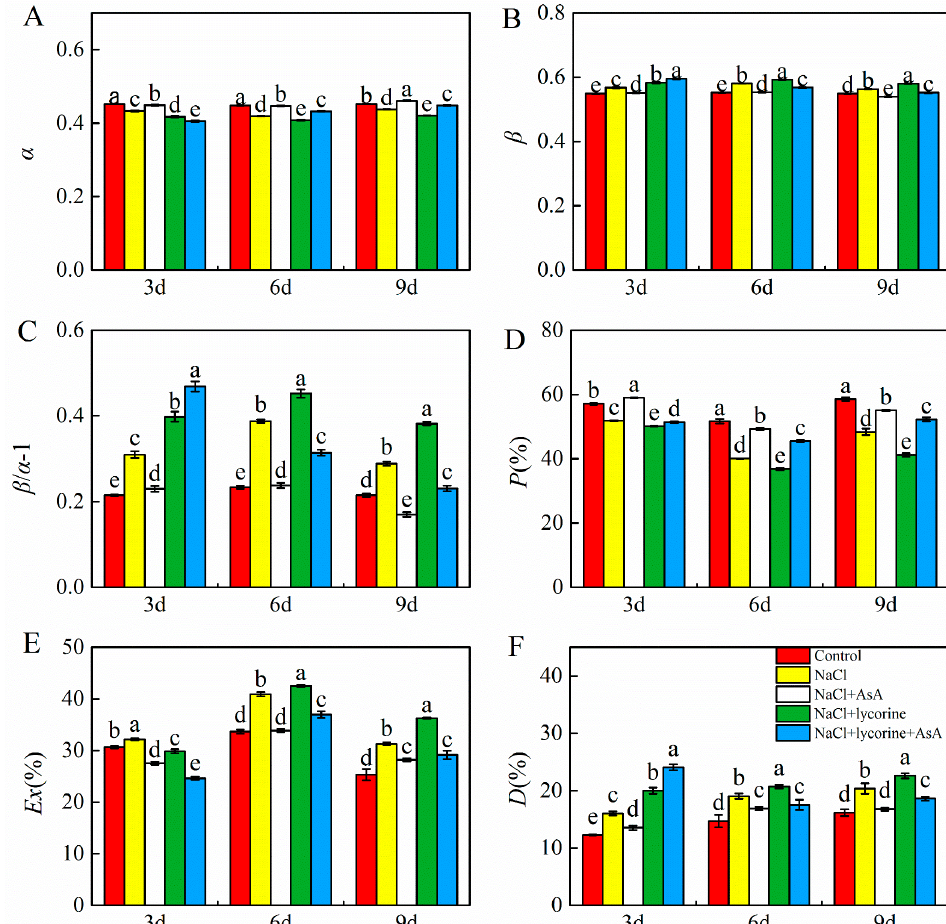
Figure 3. Values of the photon activity distribution coefficients of PSI ( α ) ( A ), the photon activity distribution coefficients of PSII ( β ) ( B ), the relative deviation from full balance ( β / α –1) between PSI and PSII ( β / α − 1) ( C ), the fraction of photon energy absorbed in PSII antennae utilized for photosynthetic electron transport ( p ) ( D ), the estimate of the fraction of excess excitation energy that is neither dissipated in the PSII antennae nor utilized for photochemistry ( Ex ) ( E ), and the fraction of photon energy absorbed in PSII antennae and dissipated via thermal energy in the antenna ( D ) ( F ) in leaves of salt-stressed tomato seedlings with or without exogenous reduced ascorbic acid (AsA) and lycorine (AsA synthesis inhibitor) spraying. Abbreviations 3d, 6d, and 9d represent the third, sixth, and ninth day after treatment, respectively. Control, no added NaCl and sprayed with distilled water; NaCl, added 100 mmol · L –1 NaCl and sprayed with distilled water; NaCl + AsA, added 100 mmol · L –1 NaCl and sprayed with 0.5 mmol · L –1 AsA; NaCl + lycorine, added 100 mmol · L –1 NaCl and sprayed with 0.25 mmol · L –1 lycorine; NaCl + lycorine + AsA, added 100 mmol · L –1 NaCl and sprayed with 0.25 mmol · L –1 lycorine plus 0.5 mmol · L –1 AsA. Values are means ± SD ( n = 3). Values with a